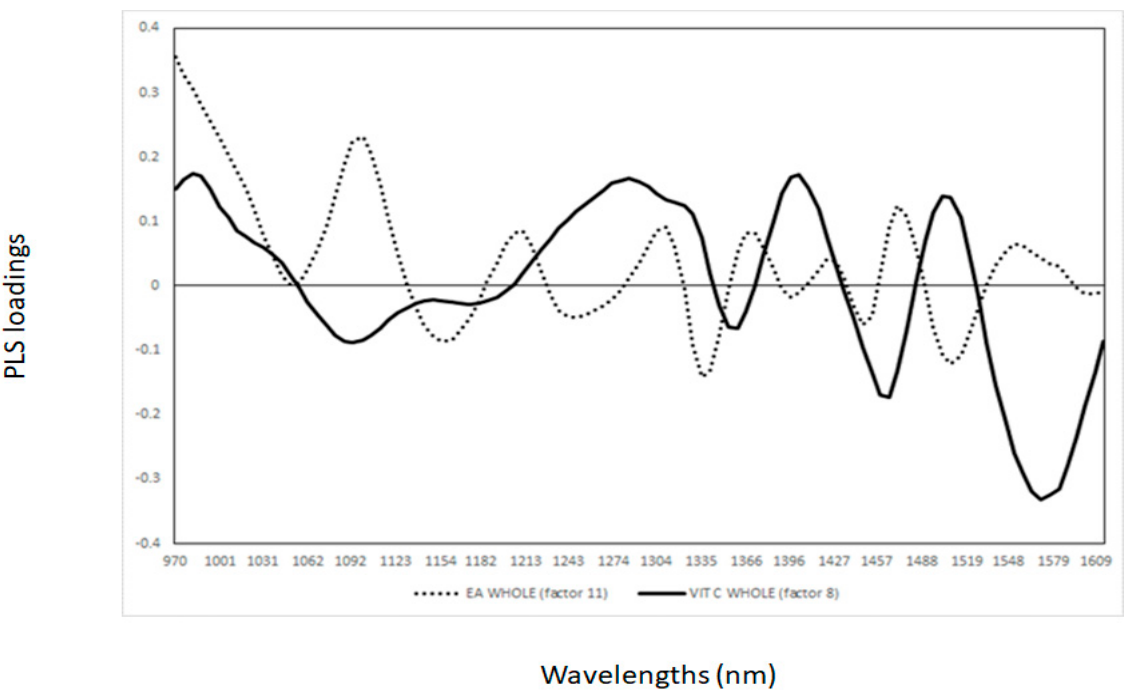
Figure 1. Partial least square loadings for the measurement of vitamin C and ellagic acid in whole Kakadu plum fruit samples.